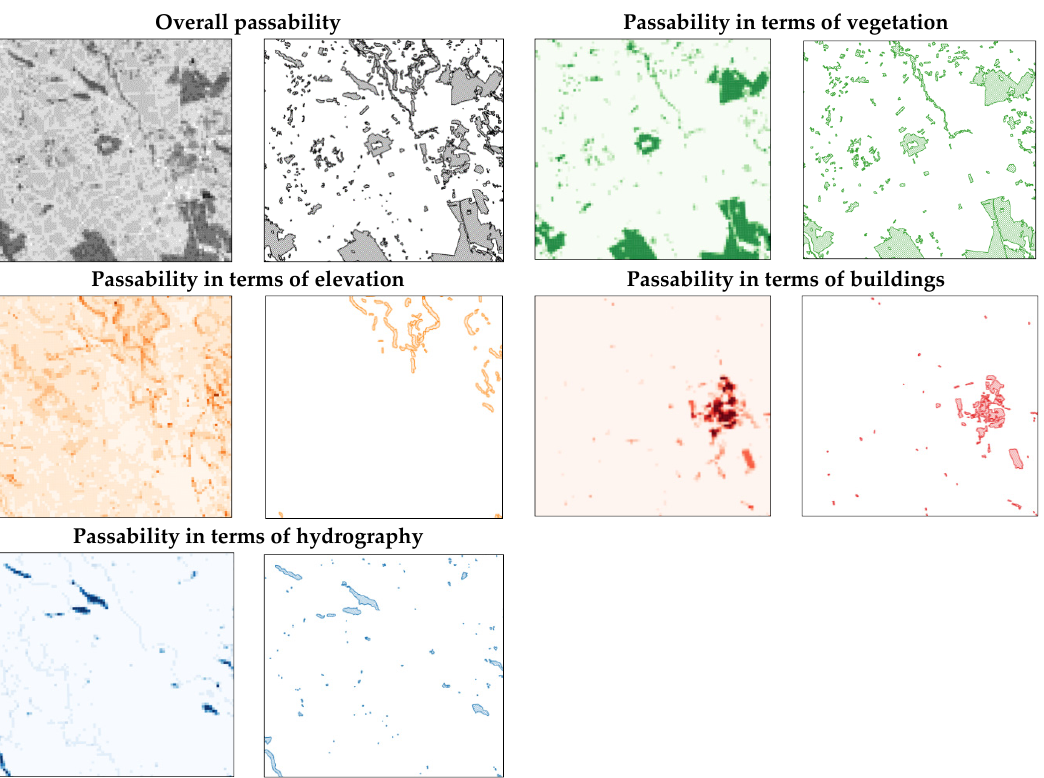
Figure 12. Fragments of a military passability map divided into topical categories of content elements.